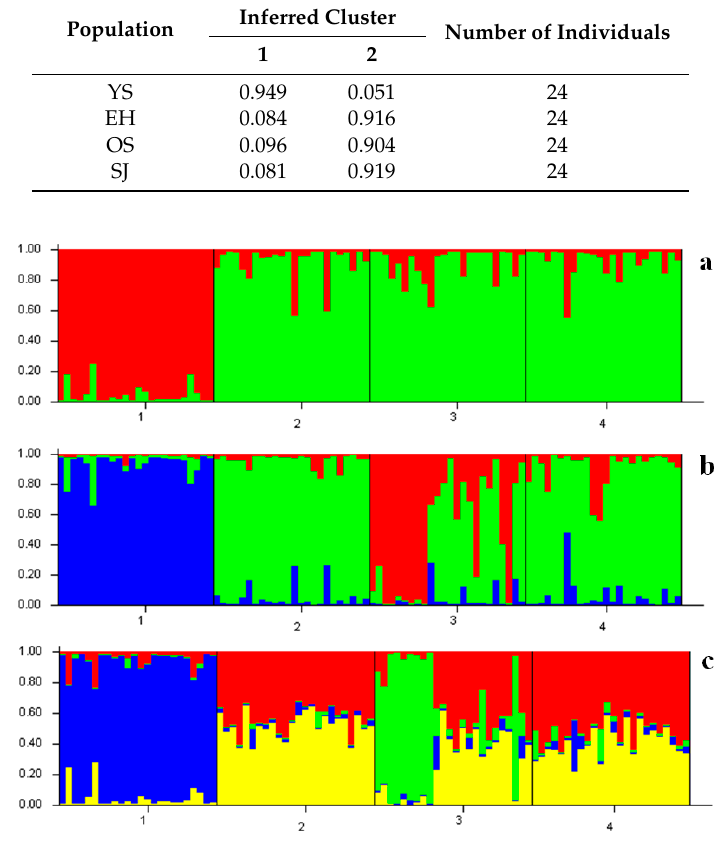
Figure 4. STRUCTURE bar plots from eight microsatellite loci for four populations of Pacific cod. Black lines separate individuals from different geographic areas. ( a ) K = 2; ( b ) K = 3; ( c ) K = 4; 1: YS; 2: EH; 3: OS and 4: SJ.